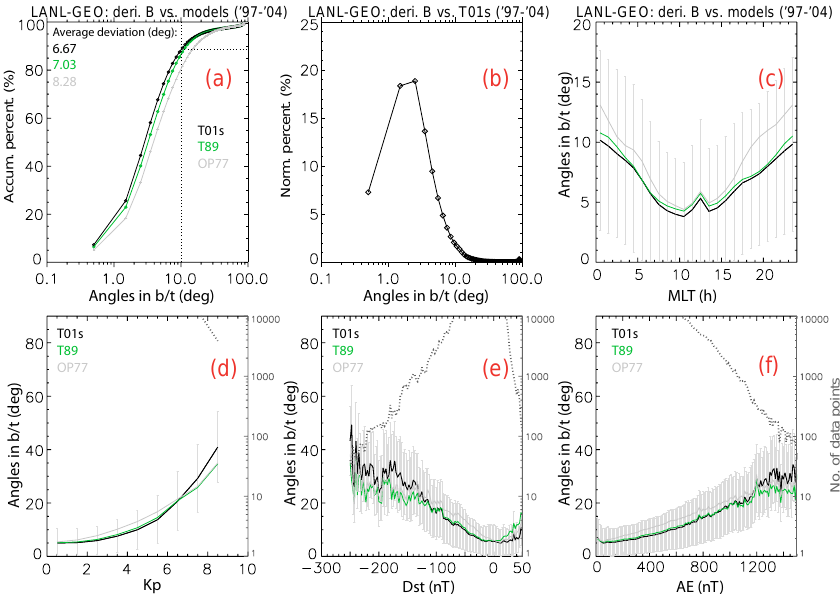
Dst (nT) Figure 10. Results from comparing derived and model magnetic field directions for all available LANL GEO data within 1997–2004. Panels have the same format as in Fig. 3. (a) Accumulative percentage vs. deviation angles between derived and simulated directions for three empirical models T01s (black), T89 (green), and OP77 (gray). Mean angle values are also presented. (b) Normalized percentage vs. deviation angles for T01s model. (c) Mean deviation angles are binned to MLT for the three models, and the vertical gray bars are the error ranges for T01s model. (d) Deviation angles are binned to Kp ranges using different colors for three models. Again, the vertical bars are error bars for T01s model. The gray dotted line plots data sample numbers (read by the vertical axis in right). (e) Deviation angles are binned to Dst. (f) Deviation angles are binned to the Auroral Electrojet Index (AE).